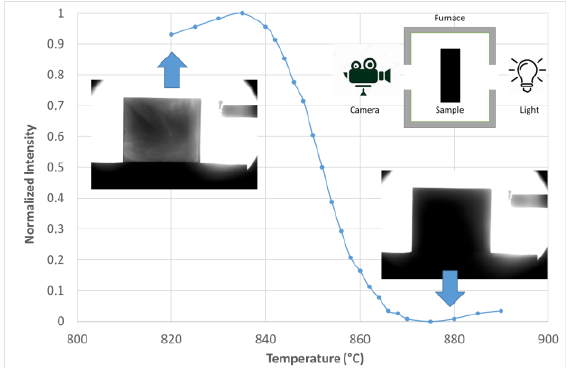
Figure 1. Principle of measurement of opacification due to the crystallization of a parent glass during the temperature rise by means of an optical dilatometer.